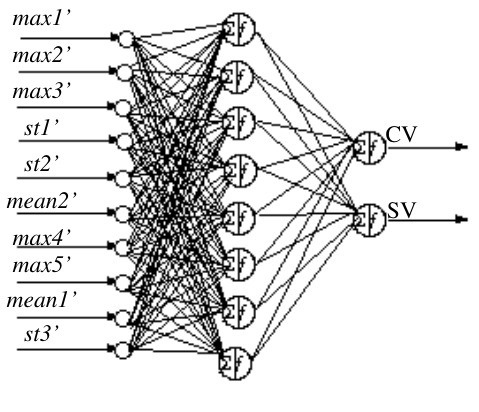
Figure 6. Vinegar classification with